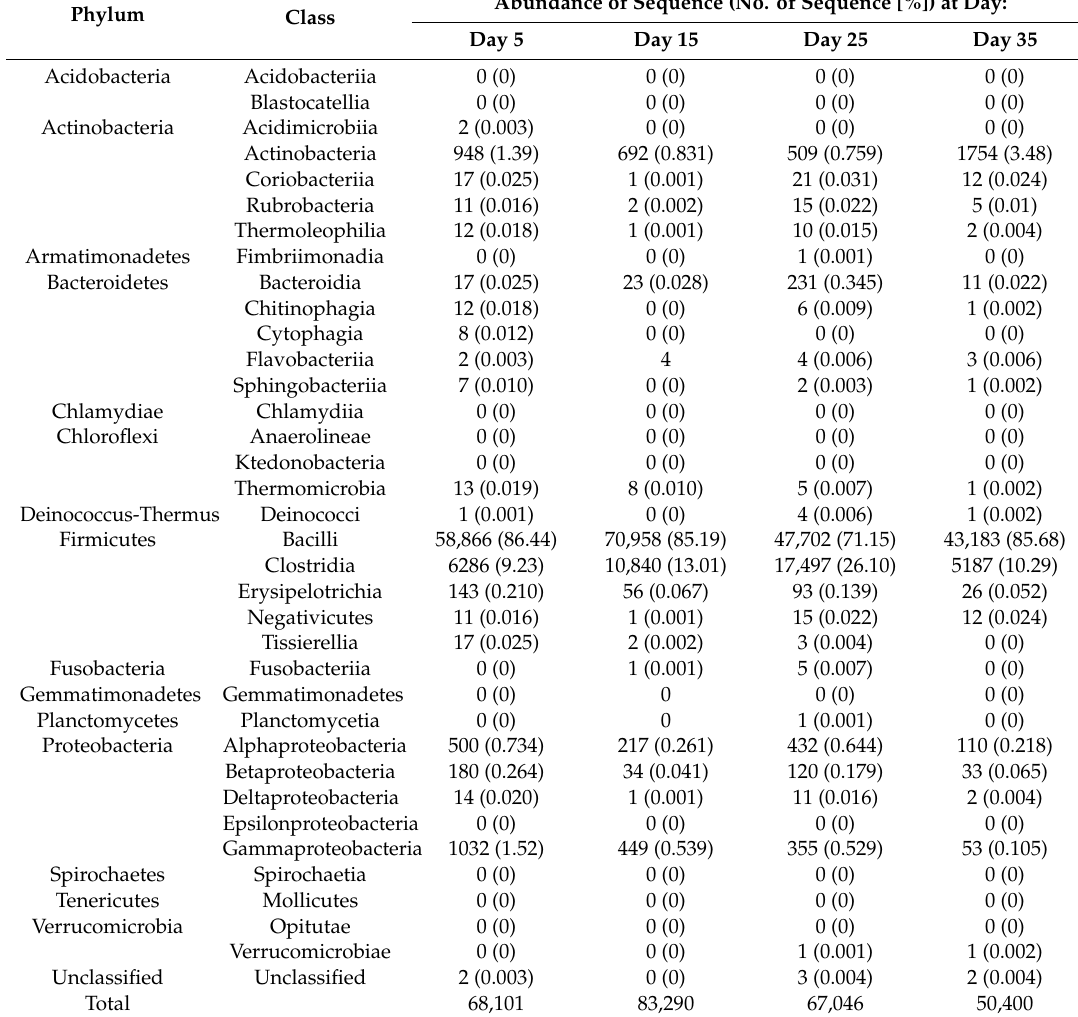
Table 9. Abundance of bacterial 16S rDNA sequences ( n = 268,837) isolated from the ileum microbiota of Omani